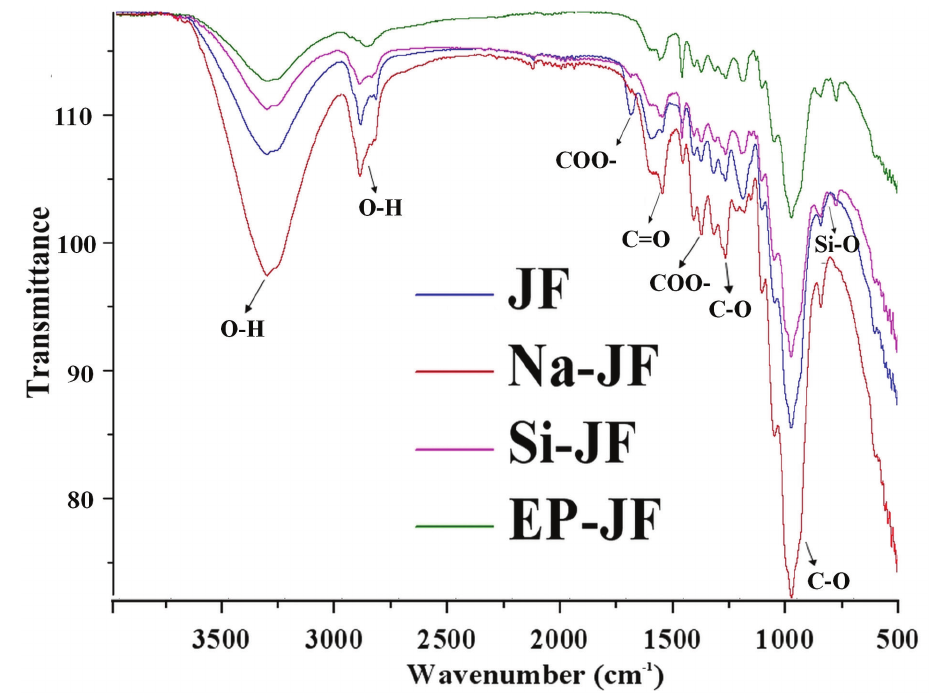
Figure 2: FTIR spectra of neat and modified JF